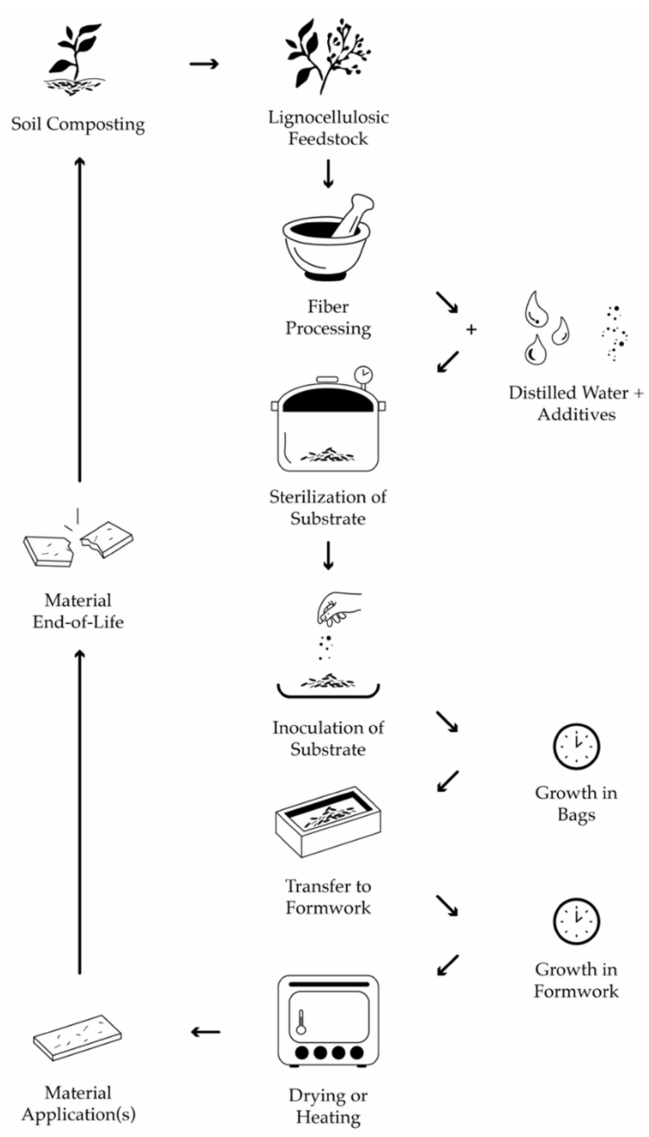
Figure 1. Typical Stages of Mycelium-Based Composite Cultivation. Diagram reworked from